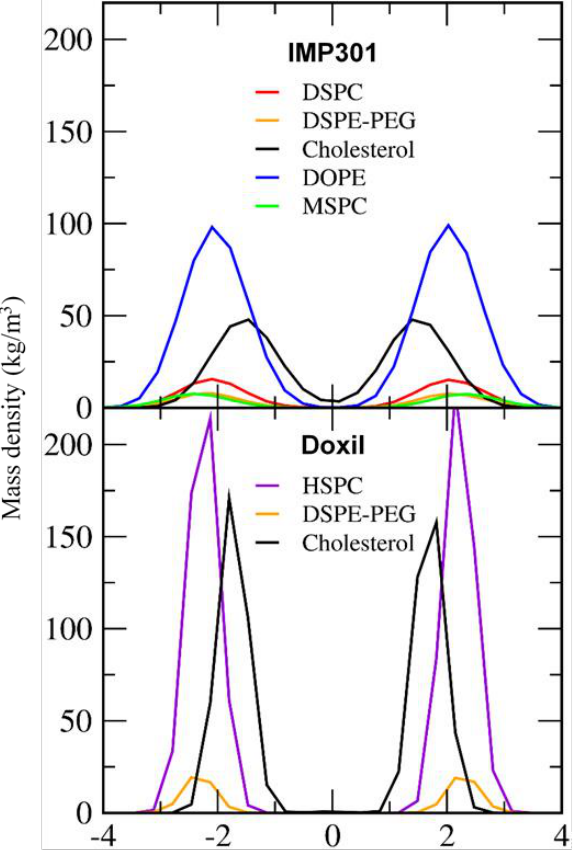
Figure 7. Mass density profiles for the phosphate group of lipids and the hydroxyl group of cholesterol for IMP301 and DOXIL.